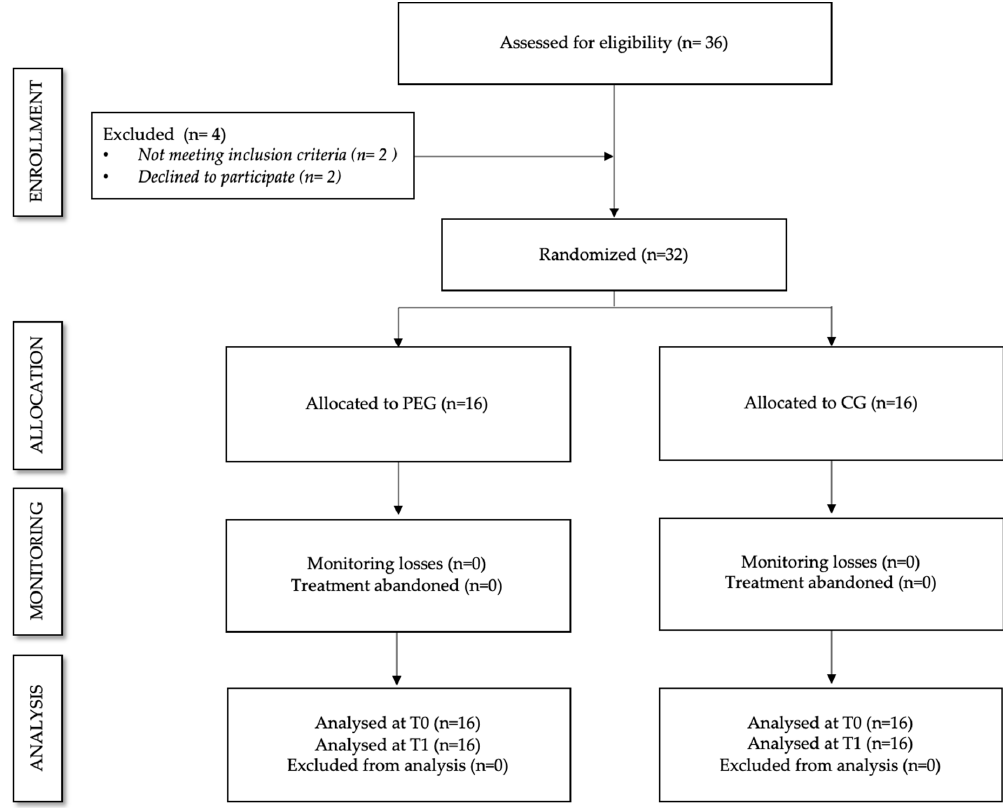
Figure 1. Flowchart according to CONSORT Statement for reporting randomized trials. PEG. Physical Exercise Group. CG. Control Group. T0. Pre-treatment assessment. T1. Post-treatment assessment.